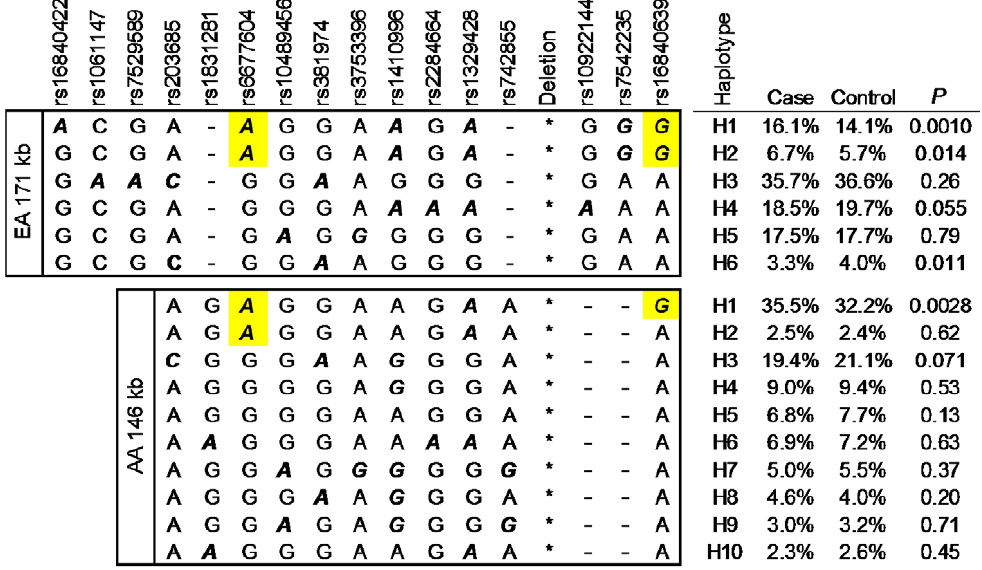
Table 2. Pairwise LD between rs6677604 and CFHR3-1 D in four ethnic groups.